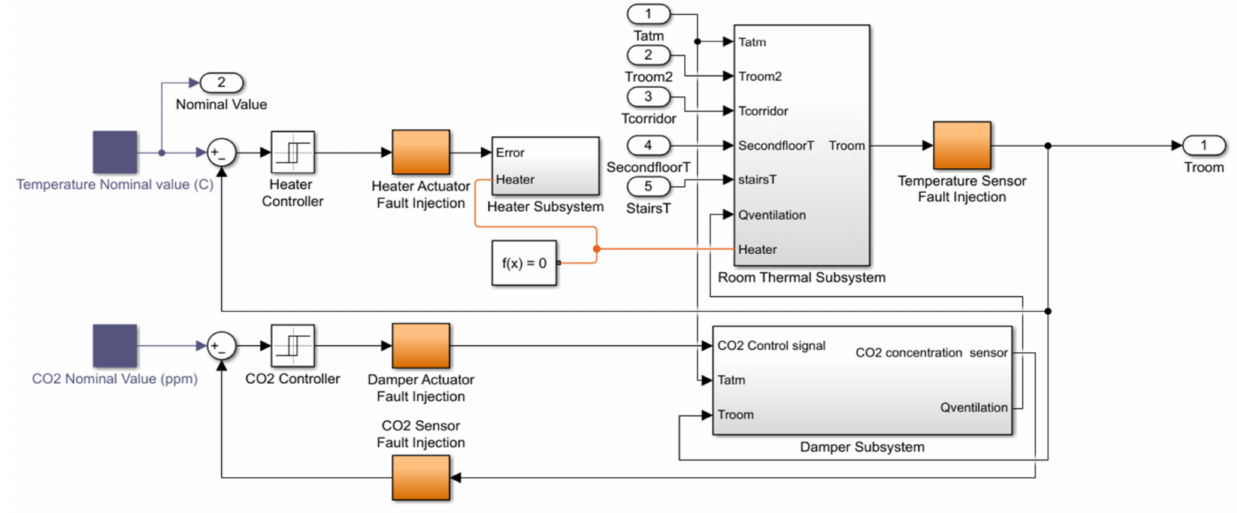
Figure 7. Model of HVAC system with DCV ventilation including fault injector blocks